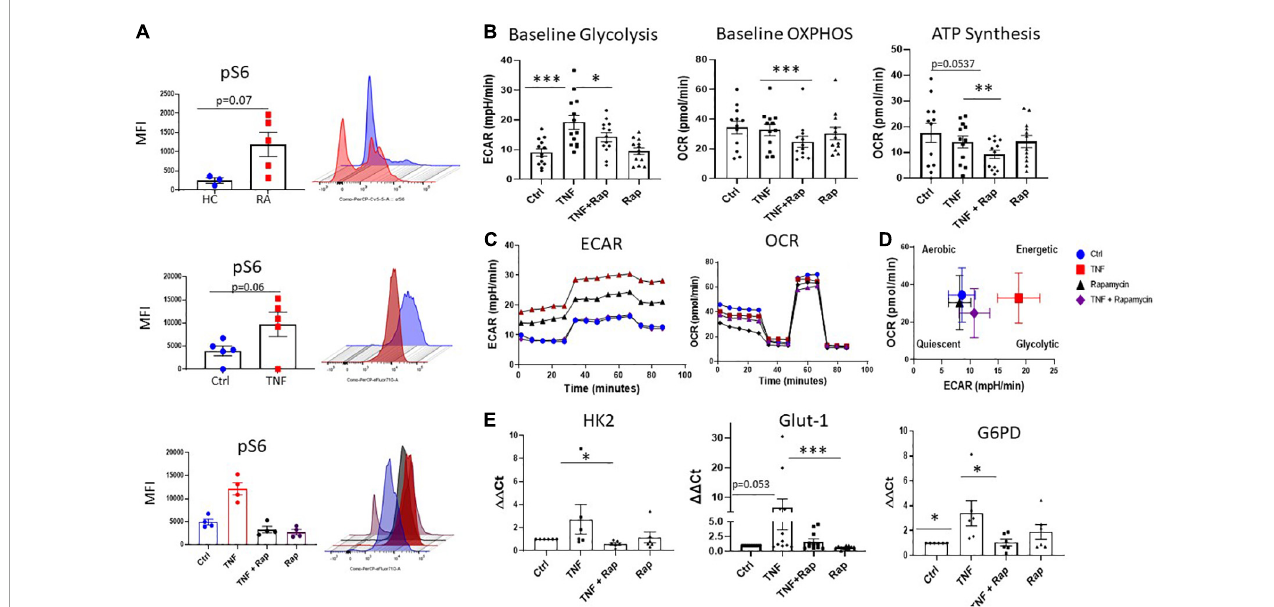
FIGURE2 Inhibition of mTOR in RA synovial fibroblasts alters cellular metabolism. (A) Representative bar graphs showing MFI expression of the downstream mTOR marker pS6 in healthy donors ( n = 3) and RA patients ( n = 5) as well as pS6 expression in RASF ( n = 5) treated with TNF α (1 ng/ml) for 24 h compared to basal control and RASF ( n = 4) treated with TNF α (1 ng/ml) and Rapamycin (100 nM) alone or in combination for 24 h. (B) Representative bar graphs demonstrating baseline glycolysis, baseline OXPHOS (oxidative phosphorylation), and ATP synthesis, in RASF treated with TNF α (1 ng/ml) and Rapamycin (100 nM) alone or in combination for 24 h ( n = 12–13). (C) Average seahorse profiles demonstrating extracellular acidification rate (ECAR) (glycolysis) and oxygen consumption rate (OCR) (oxidative phosphorylation), before and after injections of oligomycin, FCCP, and antimycin A and rotenone in RASF. (D) Metabolic phenotype profiles in RASF representing changes in metabolic phenotype in response to TNF α (1 ng/ml) and Rapamycin (100 nM) alone or in combination for 24 h. (E) Bar graphs demonstrating mRNA gene expression of hexokinase 2 (HK2), glucose-6-phosphate dehydrogenase (G6PD), and glucose transporter 1 (GLUT-1), in RASF ( n = 6–11). Fold increase compared to endogenous controls (RPLPO and HPRT1). Values expressed as mean ± SEM, Mann–Whitney t -test used for comparisons between healthy donors and RA patients. Wilcoxon signed rank test used for RASF, ∗ p < 0.05, ∗∗ p < 0.01, ∗∗∗ p <